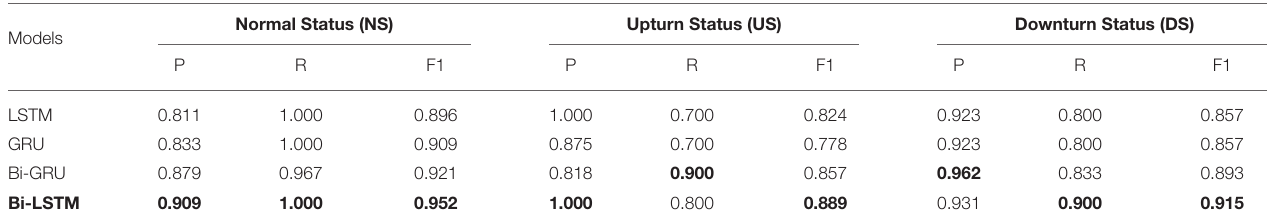
TABLE 6 | The encoder prediction performance by different company statuses.